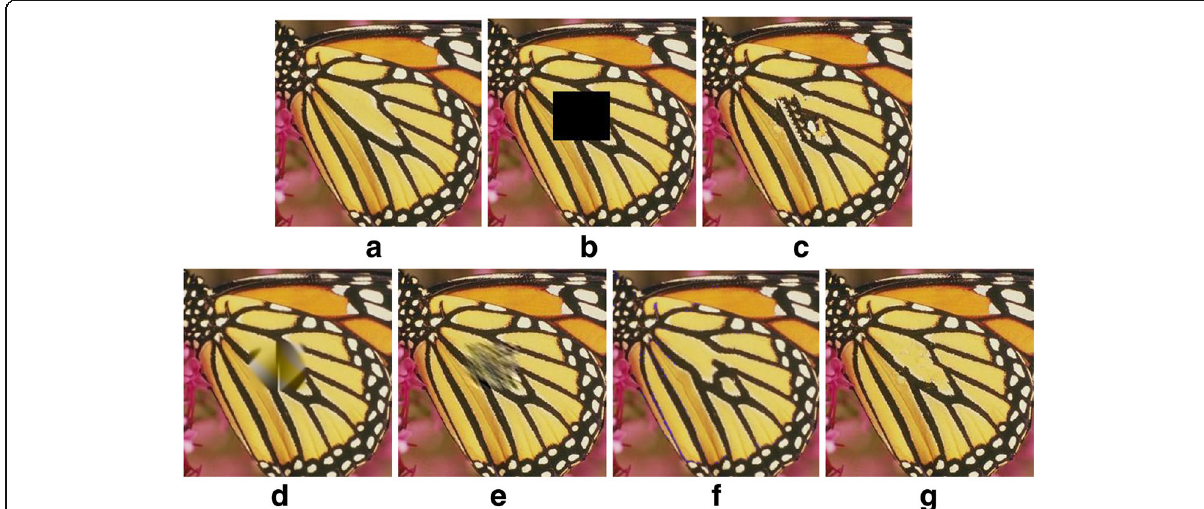
Fig. 9 The filling of a large hole. a Original. b Mask. c Crinimisi. d GSR. e ALOHA. f Melding. g